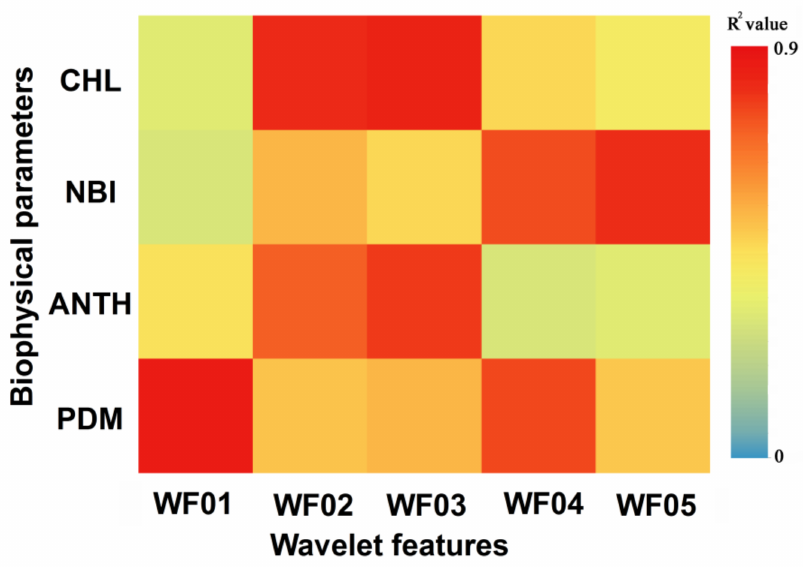
Figure 5. Correlation analysis (in coefficient of determination R 2 ) of individual wavelet features with foliar components parameters (NBI, CHL, ANTH,